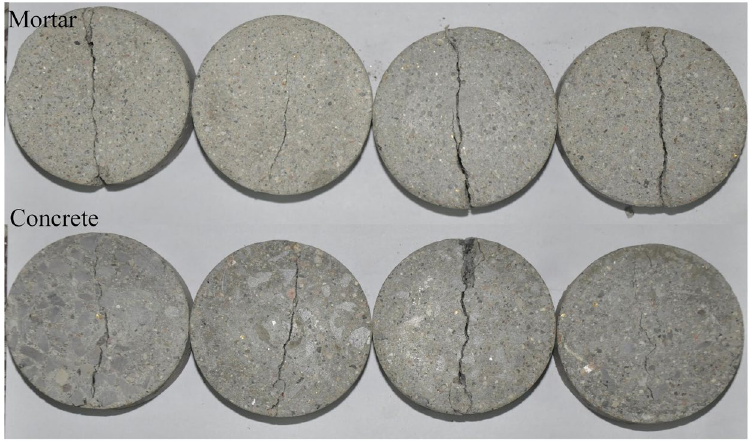
Figure 10. Failure modes of mortar and concrete BD specimens under quasi-static splitting tests with a loading rate of 0.1 mm/min.